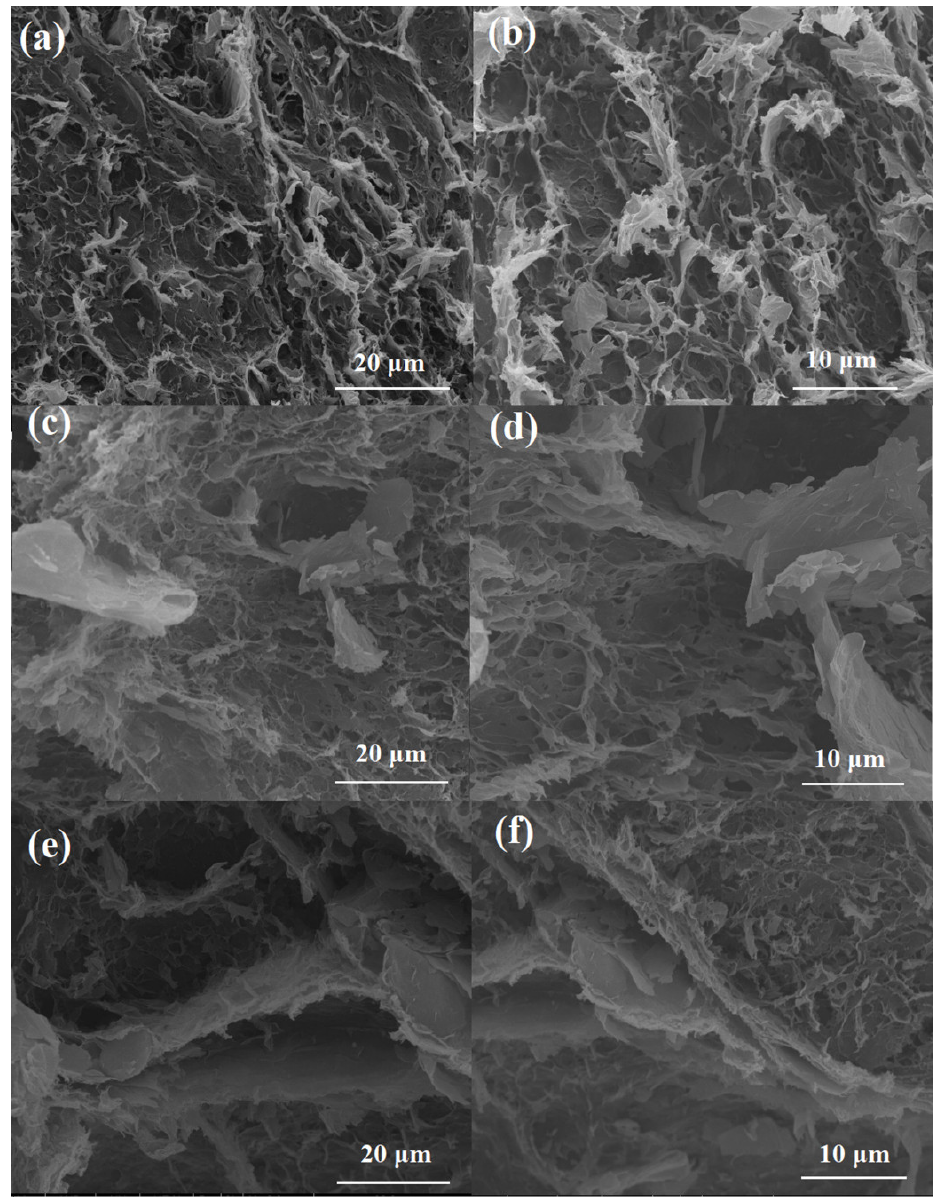
Figure 3. SEM images of GA ( a , b ), HGA1 ( c , d ), and HGA3 ( e , f